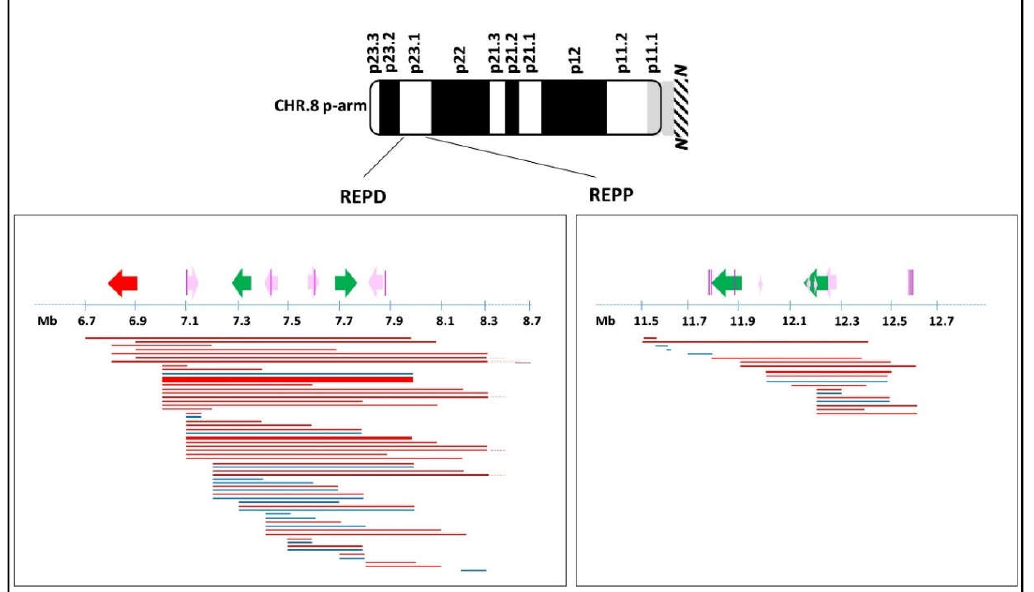
Figure 7. Schematic diagram of benign CNVs on 8p identified in our cohort. Defensin gene clusters and OR/FAM clusters are represented by colored arrows: red, α-defensin; green, β-defensin; pink, OR/FAM clusters. The direction of the arrows indicates cluster orientation. Purple vertical lines: OR7 family at 8p23.1. Horizontal lines: benign CNVs: losses are red; gains are blue. Line thickness: frequency of the CNV in our cohort where the thinnest is for ≤40 patients; the largest is for the most frequent CNV (≥500 patients); the middle lines are for intermediate situations (around 100 patients). The region of the 8q arm not shown in the figure is indicated by the N.